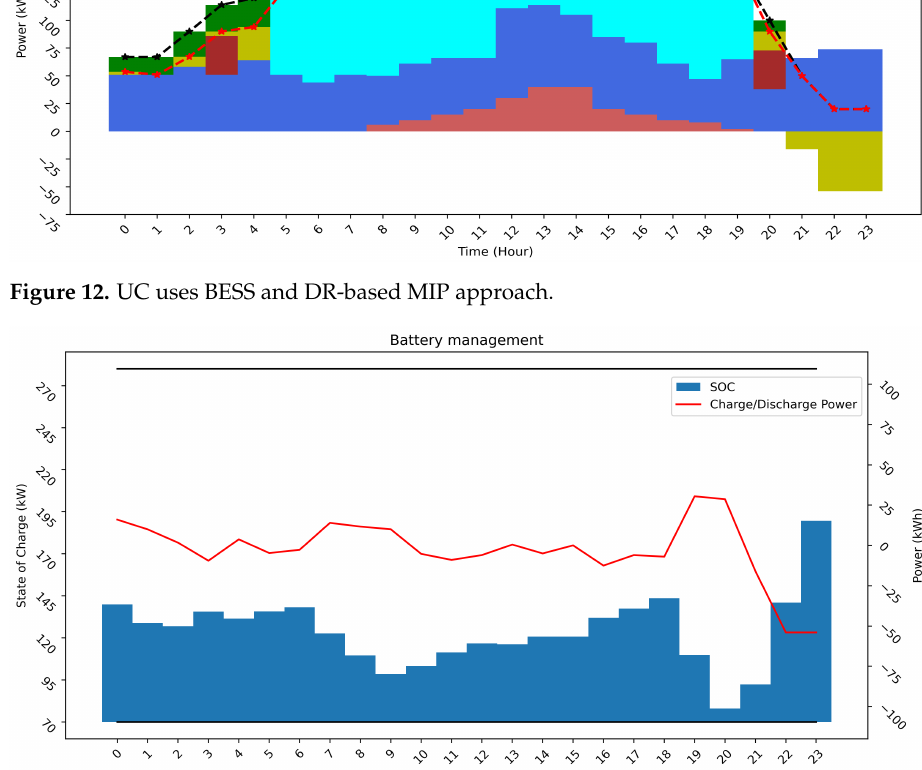
Figure 13. Management of BESS based on GA approach to case